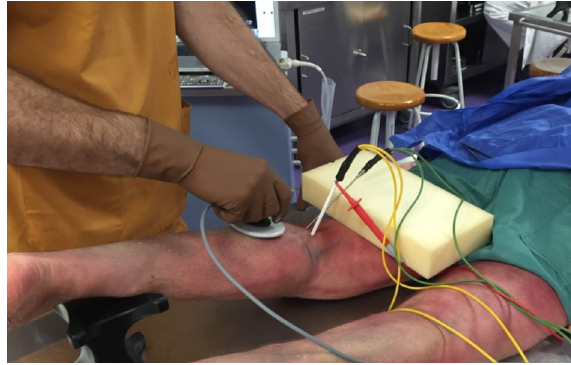
Figure 4. Intervention with T-Plus